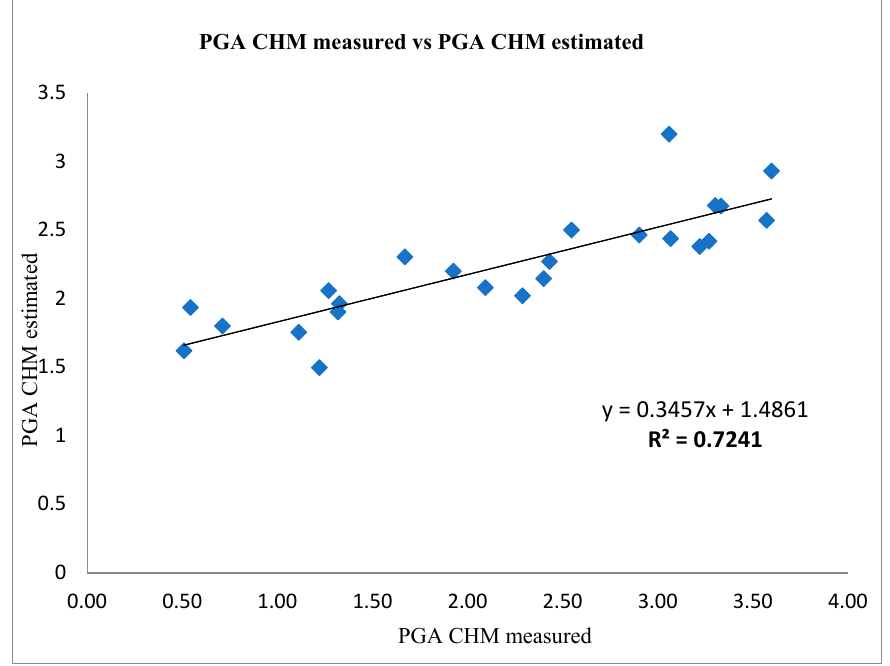
Figure 6. Measured vs. estimated CHM PGA with NDVI values > 0.30 of Tonda di Giffoni, using CHMe = 0.3457 × CHMm + 1.4861 equation; p < 0.001. In contrast, the measured PGA vs. CHM estimated with NDVI values > 0.35 of Tonda di Giffoni using the CHMe = 0.3414 × CHMm + 1.3817 equation showed statistical significance ( p < 0.001) and low regression was (R 2 = 0.5169) (Figure 7).